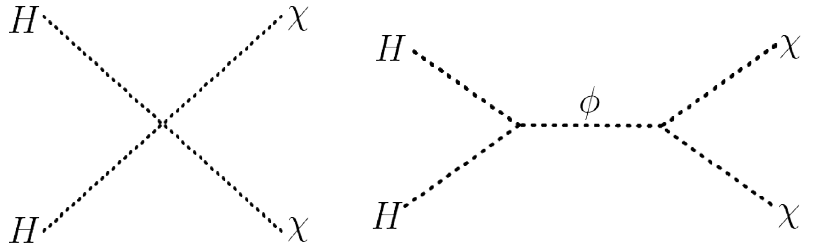
Figure 5 . The Feynman diagrams for the Majorogenesis in the scenario (B). The contact type interaction in the left panel is canceled by the low-energy contribution from the scalar mediated interaction in the right